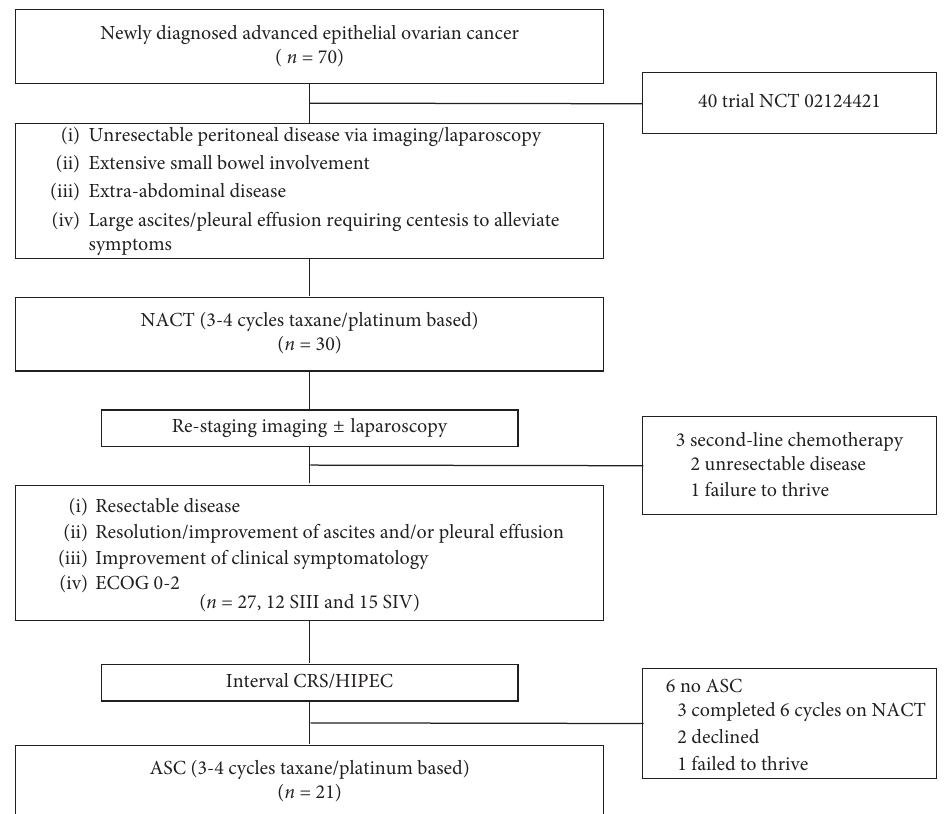
Figure 1: Management algorithm of initially unresectable stage IIIC and IV ovarian cancer patients. ASC: Adjuvant systemic chemotherapy, CRS/HIPEC: Cytoreductive surgery and hyperthermic intraperitoneal chemotherapy, ECOG: Eastern Cooperative Oncology Group Performance Status, NACT: Neoadjuvant systemic chemotherapy, SIII: Stage IIIC, SIV: Stage IVA/B. Table 1: Characteristics of epithelial ovarian cancer patients with neoadjuvant chemotherapy.